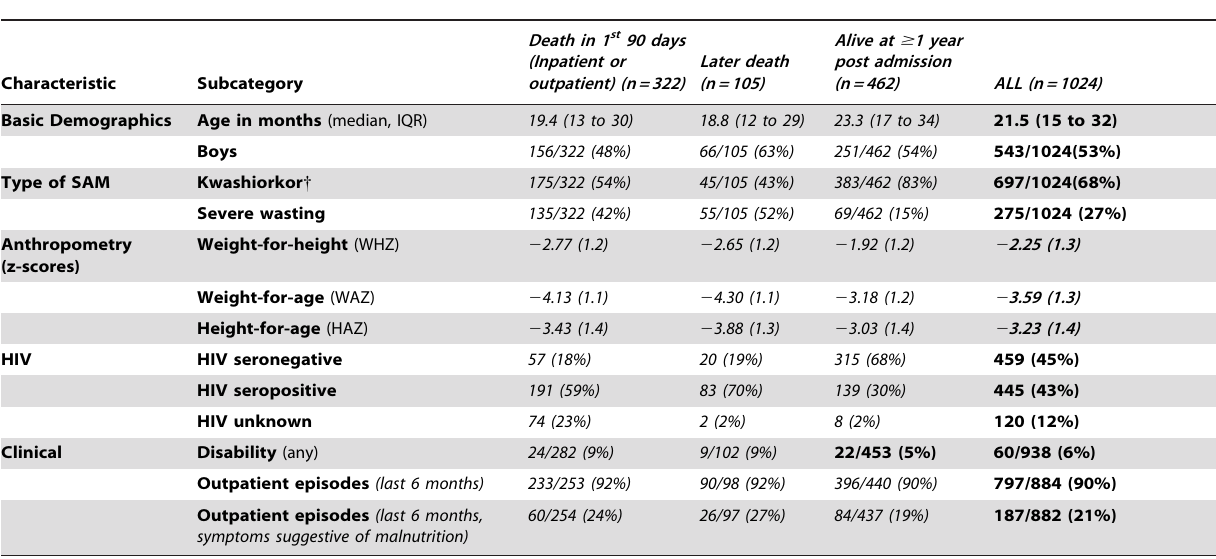
Table 1. Patient profile at baseline (initial admission), by final